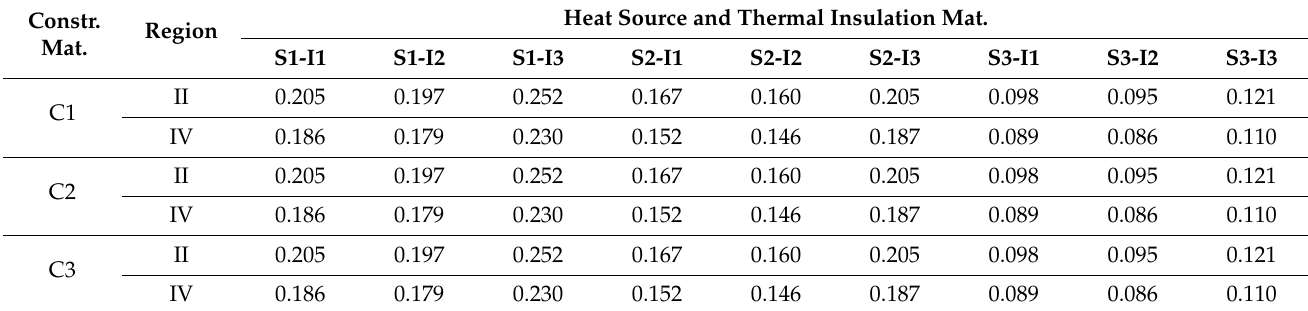
Table 7. Optimum heat transfer coefficients of the wall with a thermal insulation layer U opt (W/m 2 K). Constr. Mat.